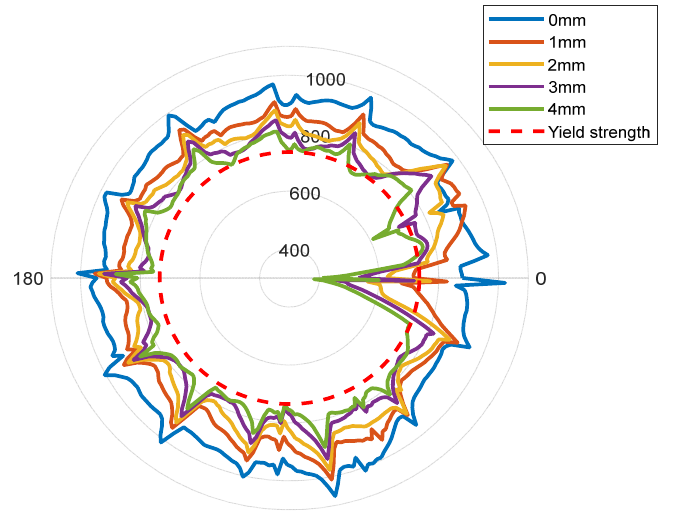
Figure 12. Contact stress distribution on the circumferential path under different wear depths.